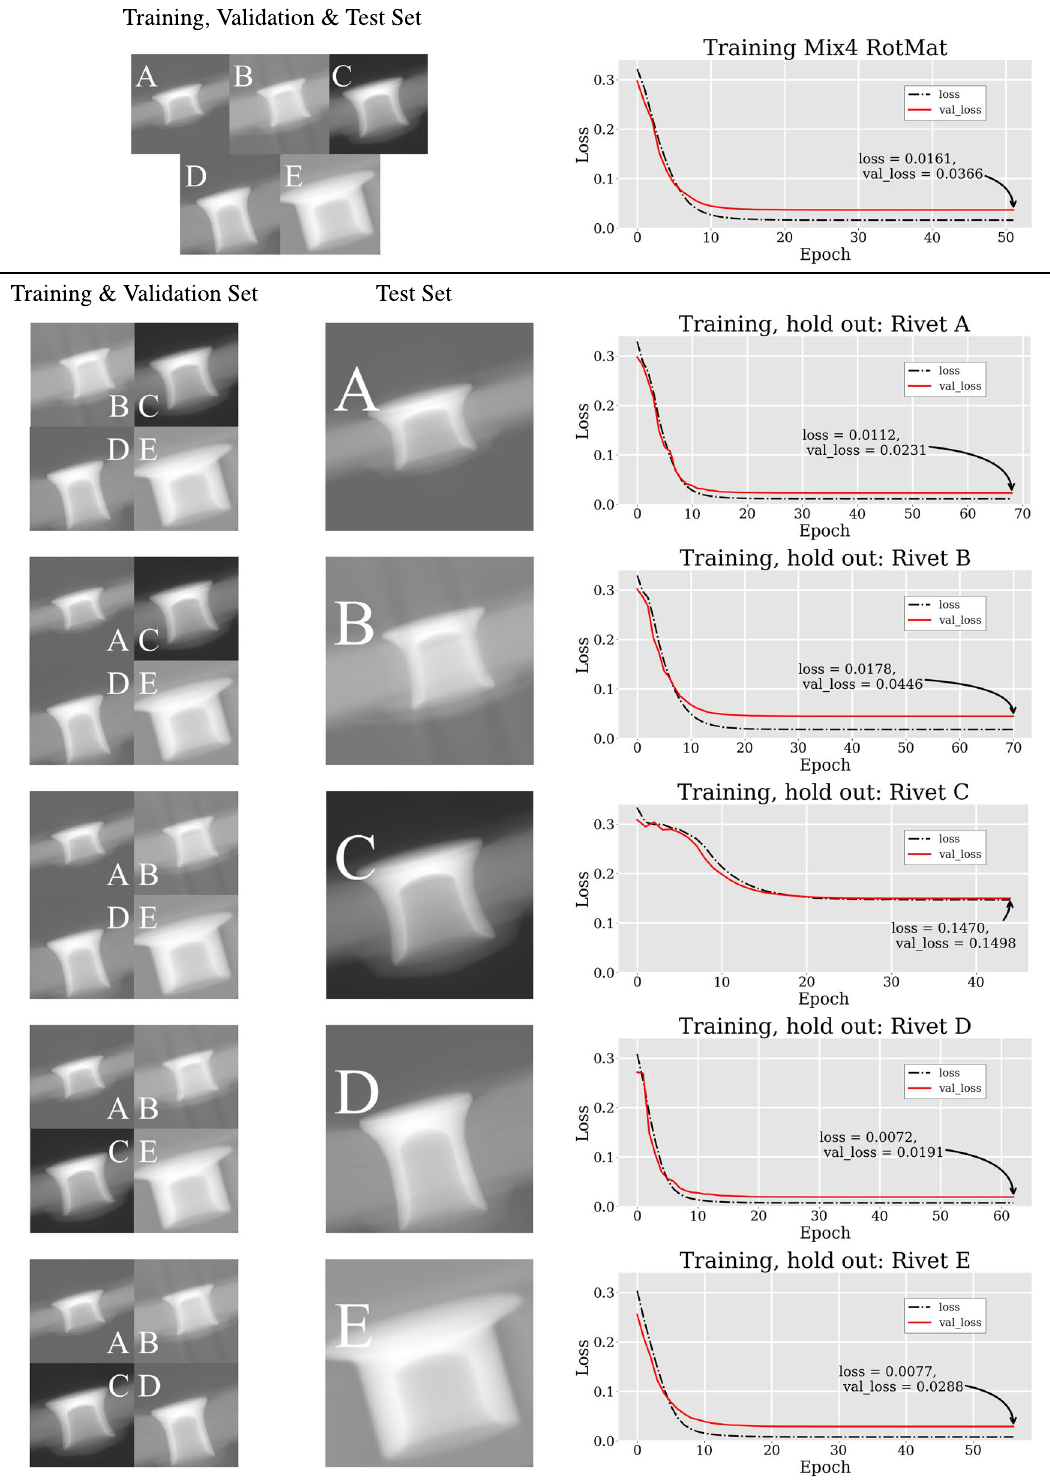
set). Using Rivet C as the hold-out set for testing had the largest impact on the training if compared with the other hold-out